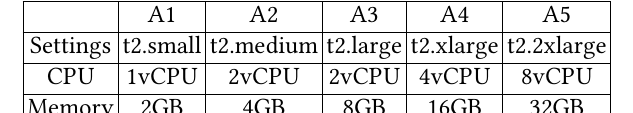
Table 3. System Configurations of VMs on Different Cloud Infrastructures